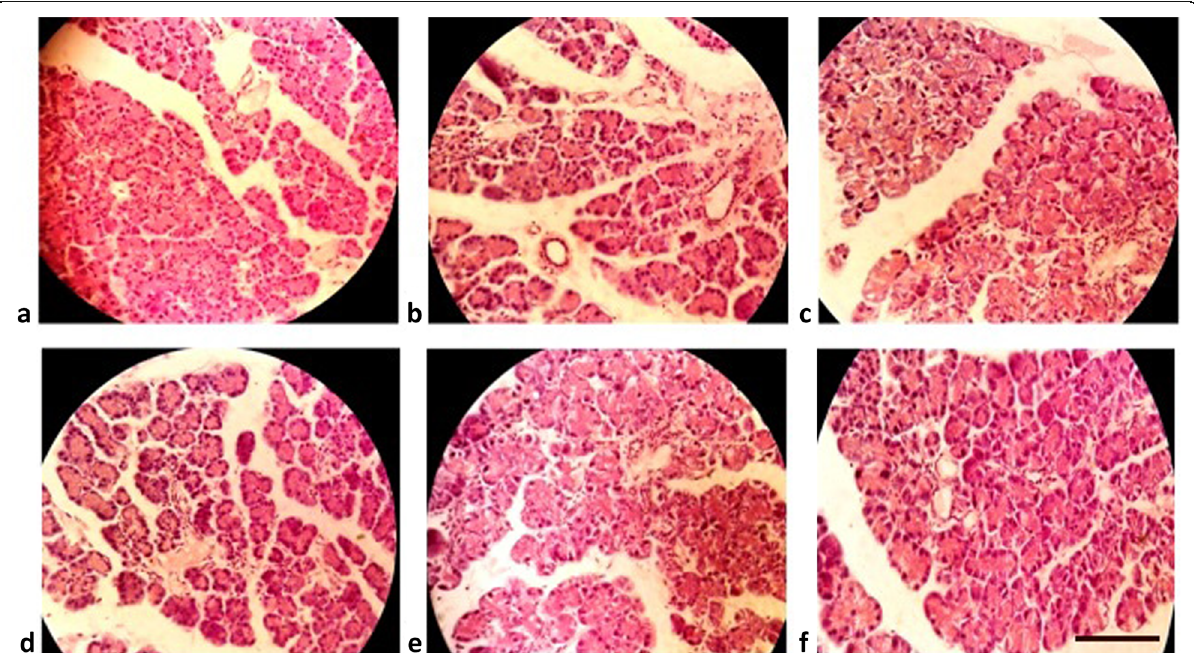
Fig. 2 Histopathology of pancrease. Each picture is a representative for each group as follows: a = Healthy control, b = Diabetic control, c = Diabetic control + 10 mg/kg of gliclazide, d = Diabetic control + 100 mg/kg CRME, e = Diabetic control + 200 mg/kg CRME, f = Diabetic control + 400 mg/kg CRME. Each group was evaluated at 400 x magnification, scale bar: 40 μ